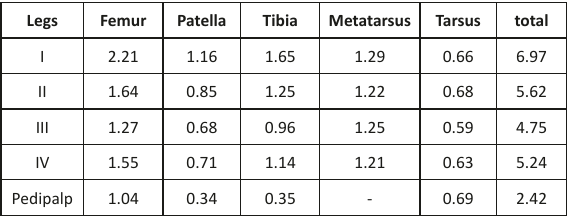
Table 1. Morphometry of legs and Palp of Epocilla praetextata from Manipur. Legs Femur Patella Tibia Metatarsus Tarsus total